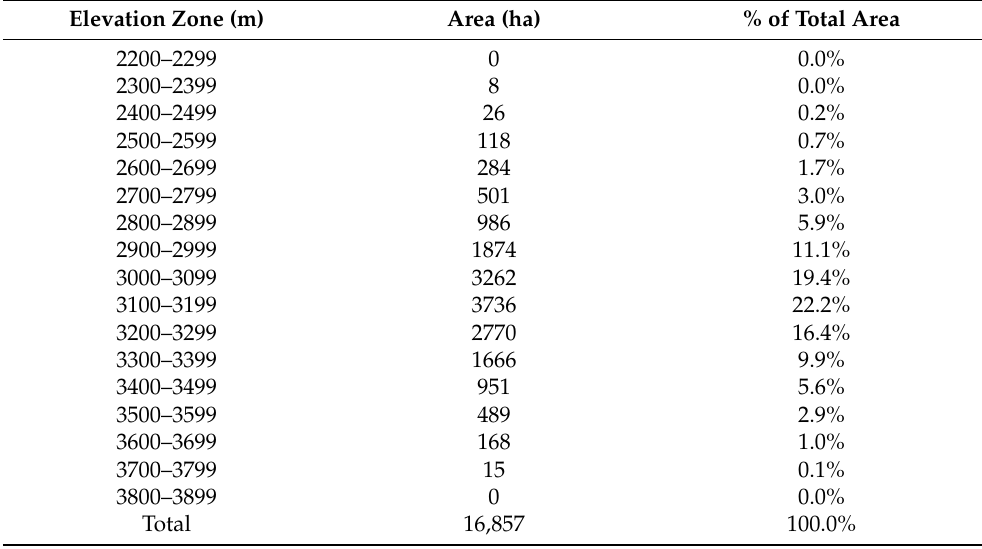
Table 1. The current actual area of A. kawakamii forest at each altitude